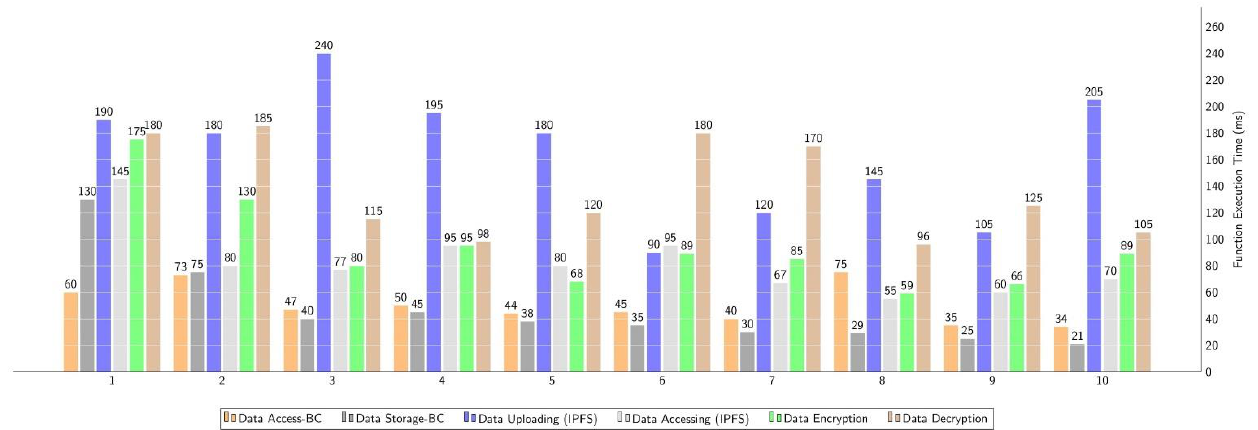
Figure 8. The computational time for function execution to store and access the data in IPFS and Blockchain.